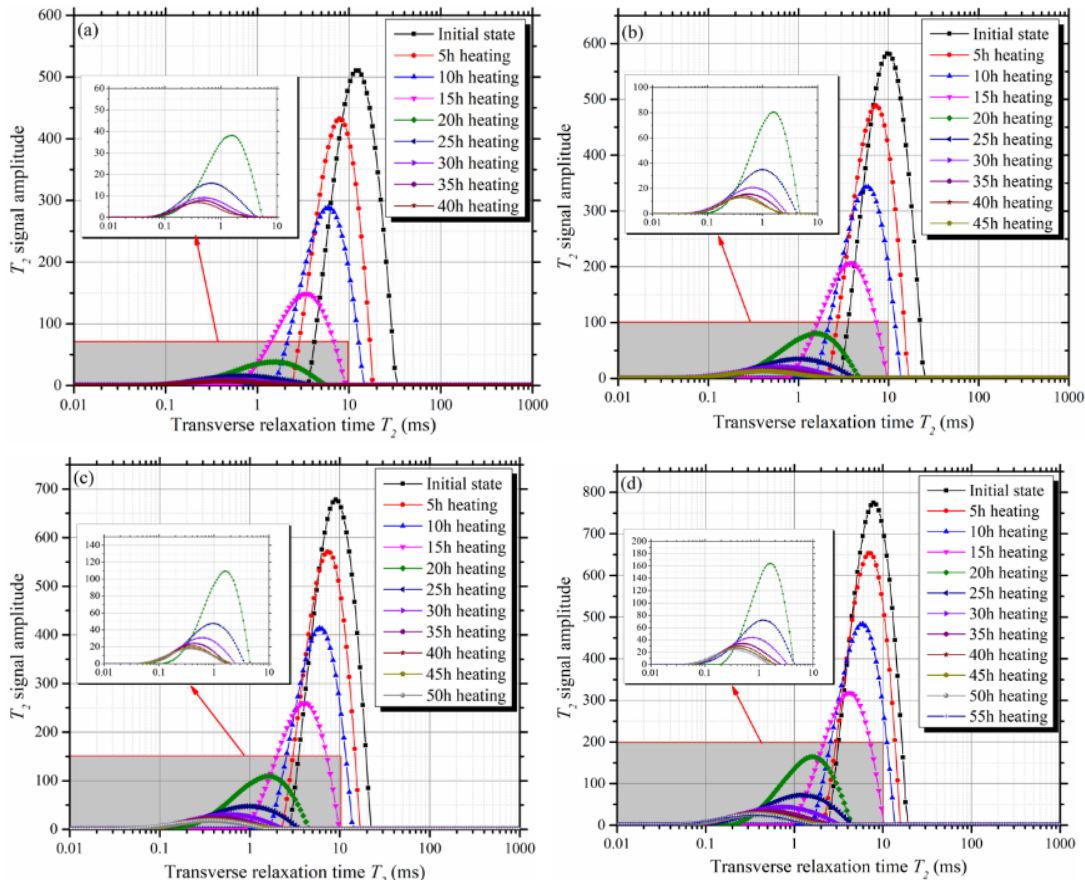
Figure 7. The variation of T 2 spectra of kaolinite-quartz mixtures: ( a ) K40; ( b ) K60; ( c ) K80; ( d ) K100. In ( a – d ), from top to bottom, curves with di ff erent colors and symbols with di ff erent shapes indicate T 2 spectra of kaolinite-quartz mixtures after heating at di ff erent times. The T 2 spectra in the box were enlarged and placed in the upper left corner of ( a – d ).